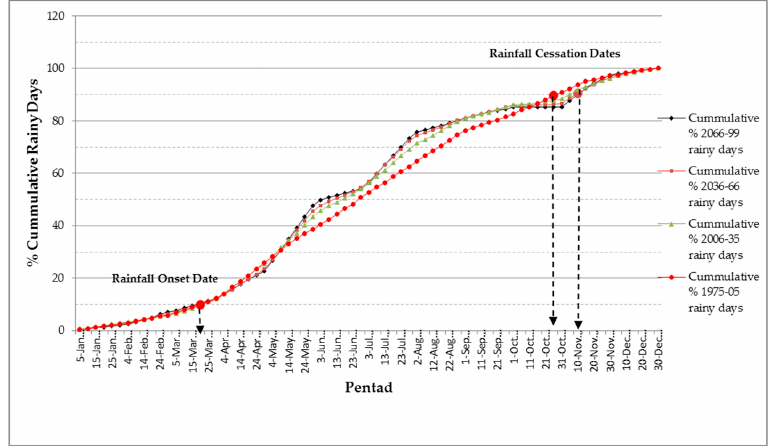
Figure 11. Kaabong Future Mean Rainfall Onset and Cessation for Rainy Days (TRMM rainfall (1975–2005) and projected (CanESM2) 2006–2035, 2036–2065 and 2066–2099.